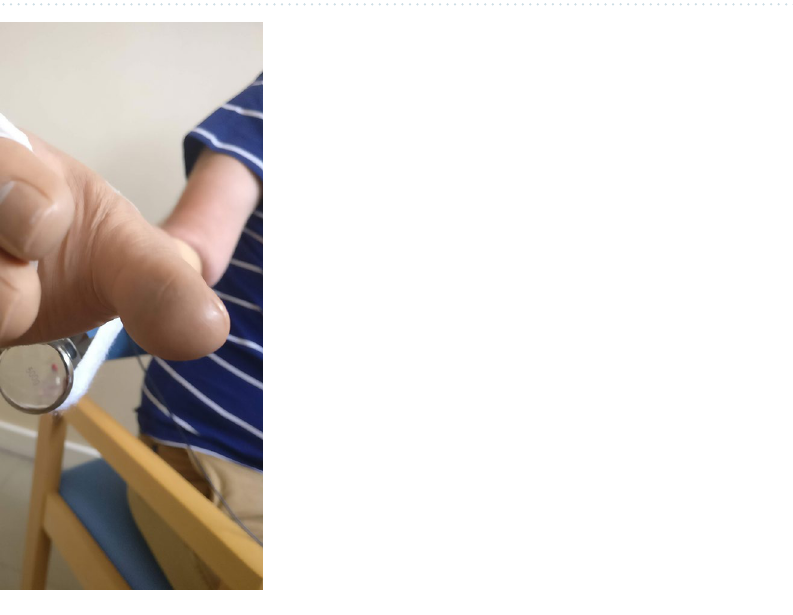
Figure 3. 500 g Load added to prosthetic hand. The load was bandaged to the hand at the proximal palm/distal wrist level so as not to disrupt the opening/closing of the